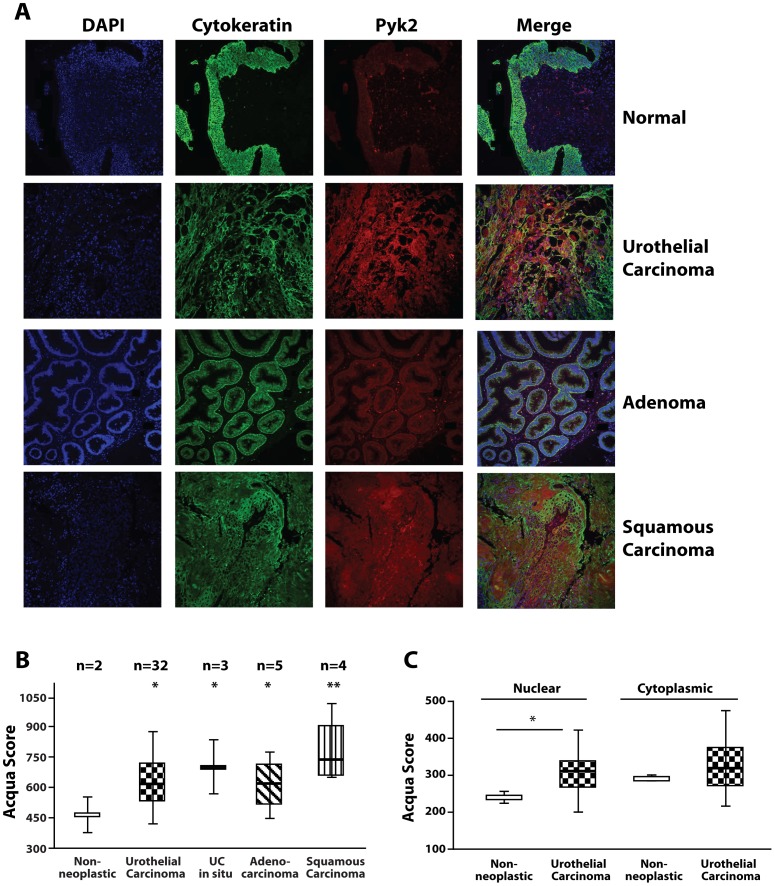
Pyk2 is up-regulated in bladder cancer tissues.(A) Pyk2 expression on a bladder cancer tissue microarray was determined by immunofluorescence and AQUA analysis using the AQUA PM-2000 system (HistoRx, Inc). Automated quantification and statistics on the different types of bladder cancer tumor tissues (B) and in the cytoplasmic and nuclear fractions of urothelial carcinoma cells (C) was calculated by AQUA Software. (B) *P<0.05. **P<0.01 compared to normal tissue controls. (C) *P = 0.012 compared to non-neoplastic nuclear fraction.